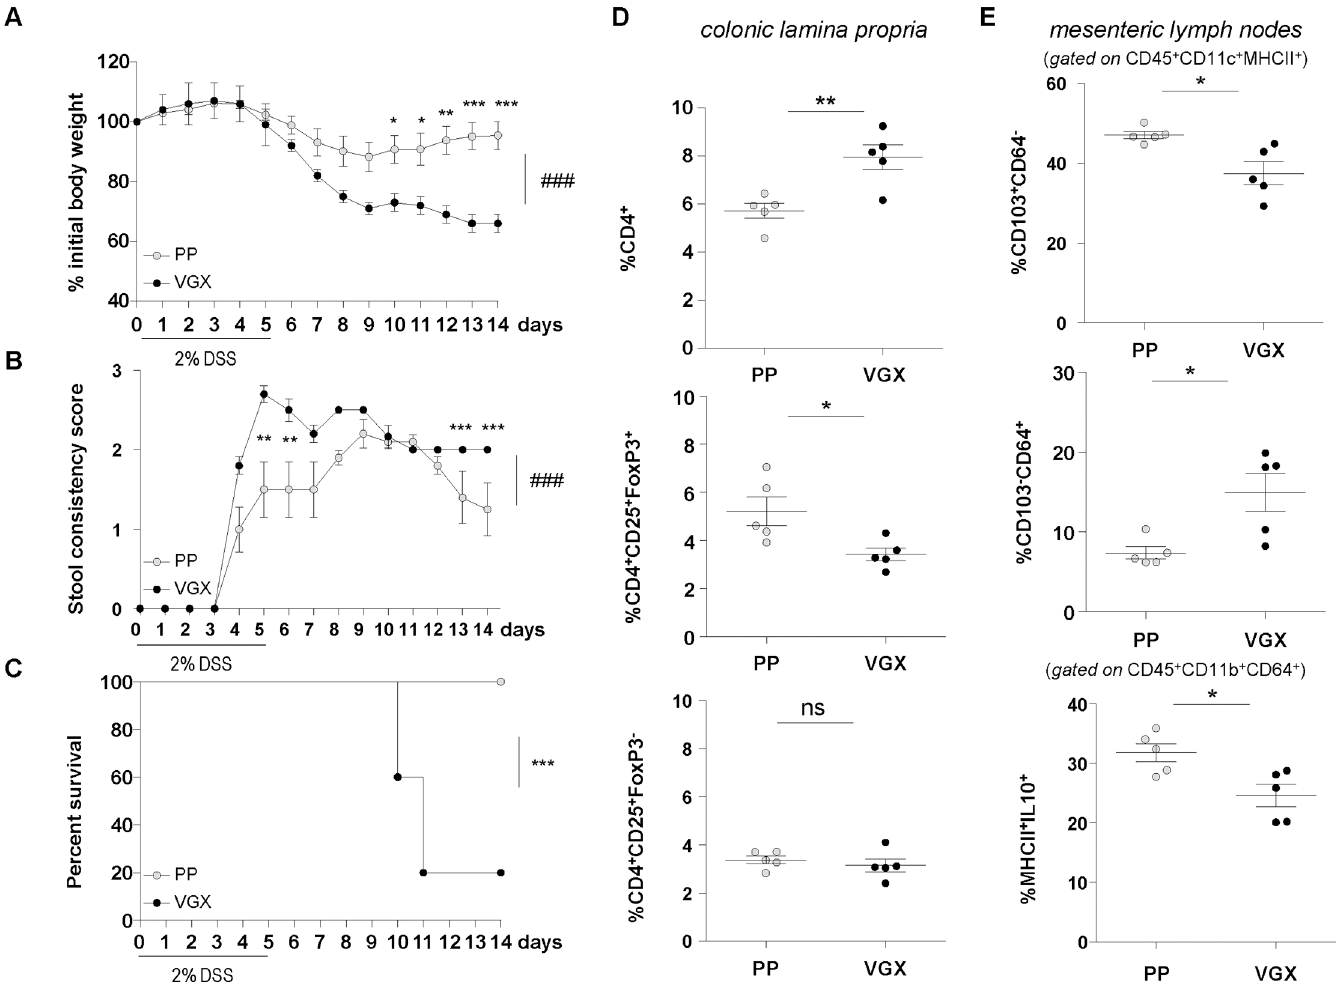
Figure 2. Vagotomy worsens the severity of DSS-induced colitis. Wild type C57BL/6 mice were subjected to vagotomy (VGX) or pyloro- plasty (PP) 2 wks before treatment with 2% DSS in drinking water for 5 d followed by 9 d of normal drinking water. Body weight (A) and stool consistency score (B) were assessed daily. Statistical significance was determined using a multivariate linear model after a post-hoc Bonferroni-Holm correction (### P < 0.001, * P < 0.05, ** P < 0.01, *** P < 0.001). (C) Mortality is expressed as survival rate and shown by Kaplan-Meier survival curves. Data are representative of two independent experiments. Statistical significance of Kaplan-Meier survival curves was determined with Log-rank (Mantel-Cox) Test (***, p = 0.0004). At d 7 after induction of DSS-colitis, PP and VGX mice were sacrificed. Colonic lamina propria immune cells were characterized by flow cytometry. (D) Frequencies of colonic CD4 + T cells, CD25 + FoxP3 + Tregs and CD25 + FoxP3 - T cells are shown. (E) Frequencies of innate immune cells, CD103 + and CD64 + antigen presenting cells isolated from the MLNs. Dots represent frequencies of immune cells in individual mice. Mean ± SEM is also shown. Data are representative of two independent experiments. Statistical significance was determined with the unpaired Student t-test (* P < 0.05, ** P < 0.01; ns, not